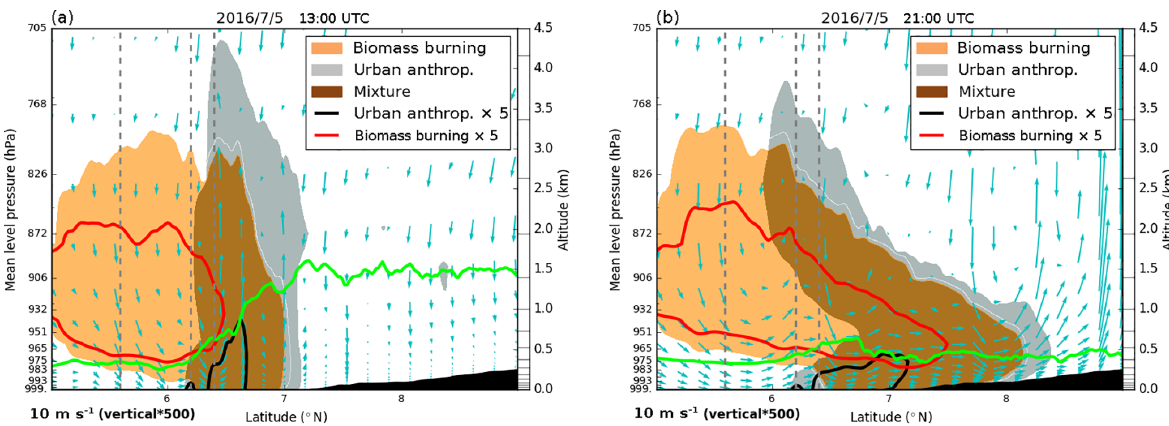
Figure 10. Meridional–vertical transect of concentrations of URB (in gray) and BB (in brown) numerical tracers on 5 July 2016 at 13:00UTC (a) and at 21:00UTC (b) . PBL top height from the WRF model is the green line. The vertical dashed gray lines show the latitude of Accra (5.6 ◦ N), Lomé (6.2 ◦ N), and Cotonou (6.4 ◦ N). The black area is the topography. Vectors (light blue arrows) represent wind in the plan of the transect (with an aspect ratio of 500 between the meridional and vertical